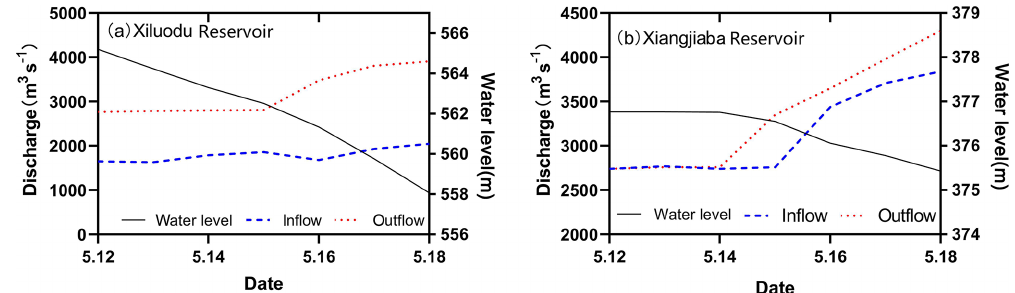
Figure 8. Hydrograph for daily average inflow, outflow and reservoir water level in the (a) Xiluodu and (b) Xiangjiaba